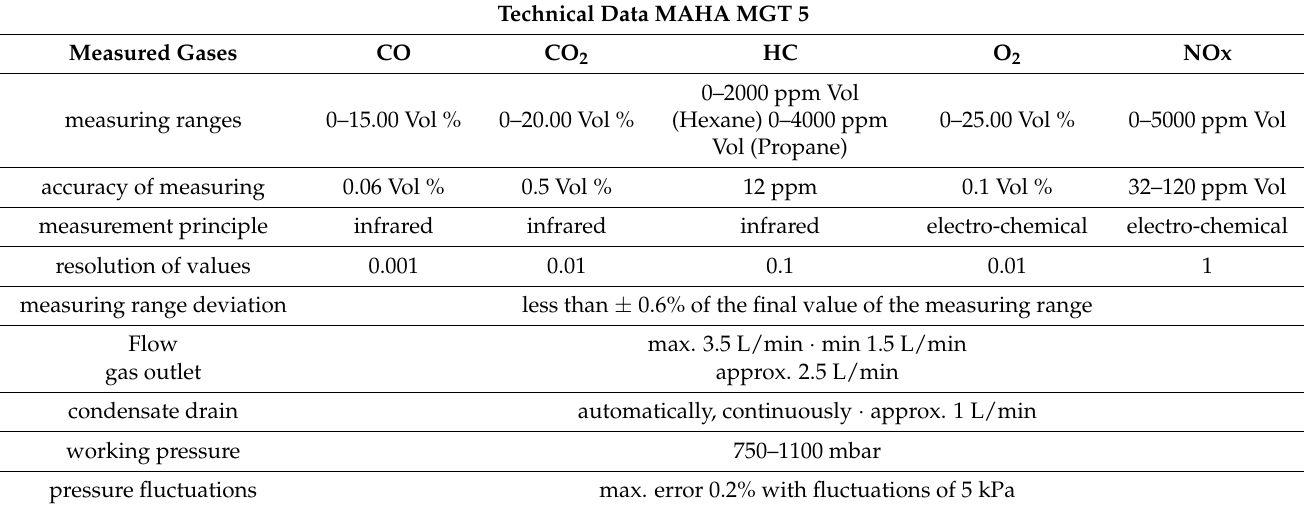
Table 2. Technical data MAHA MGT 5